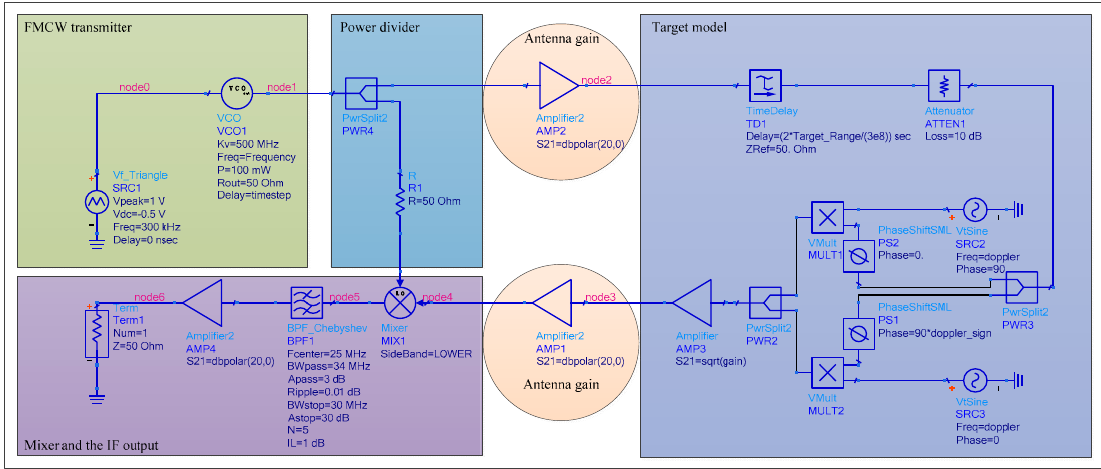
Figure 8. The composition of the circuit model of the FMCW radar.